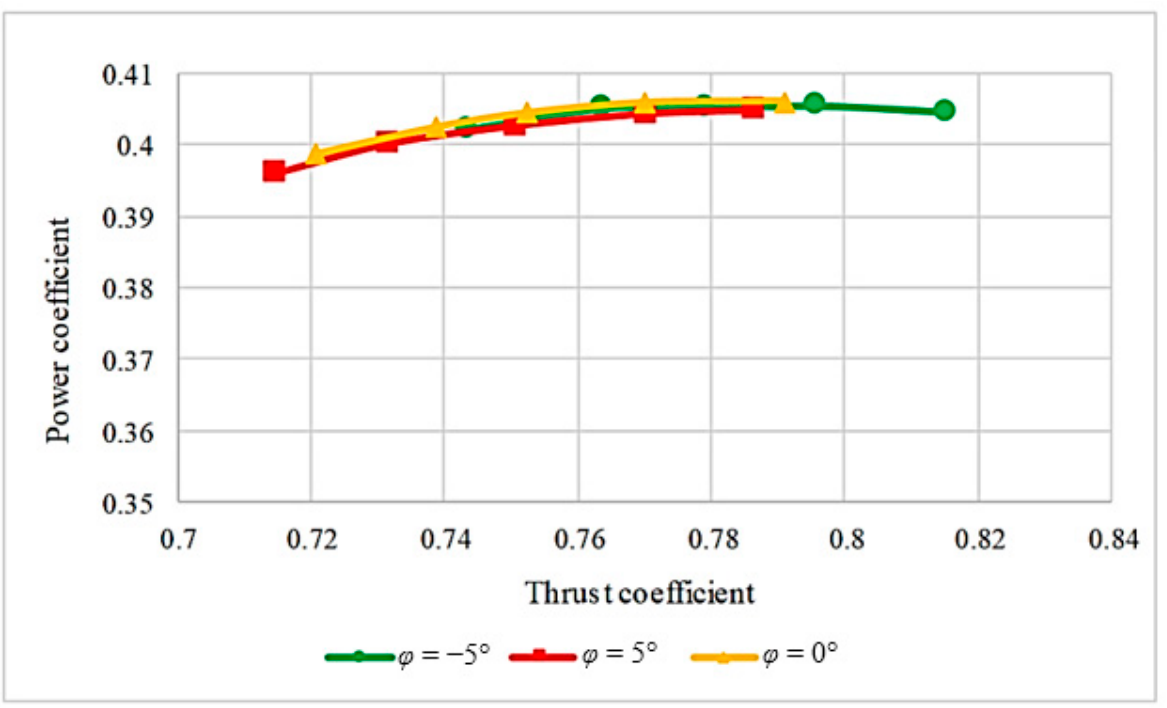
Figure 8. Relationship between the power and thrust coefficient when the change of the yaw angle is φ = − 5°, 5° and 0° at θ = 0°. The pitch angle changes from − 1° to 1° at 0.5° intervals. The yaw angles of φ = − 5°, 0°, 5° are green, red, and yellow color lines, respectively. At the yaw angle declination, the